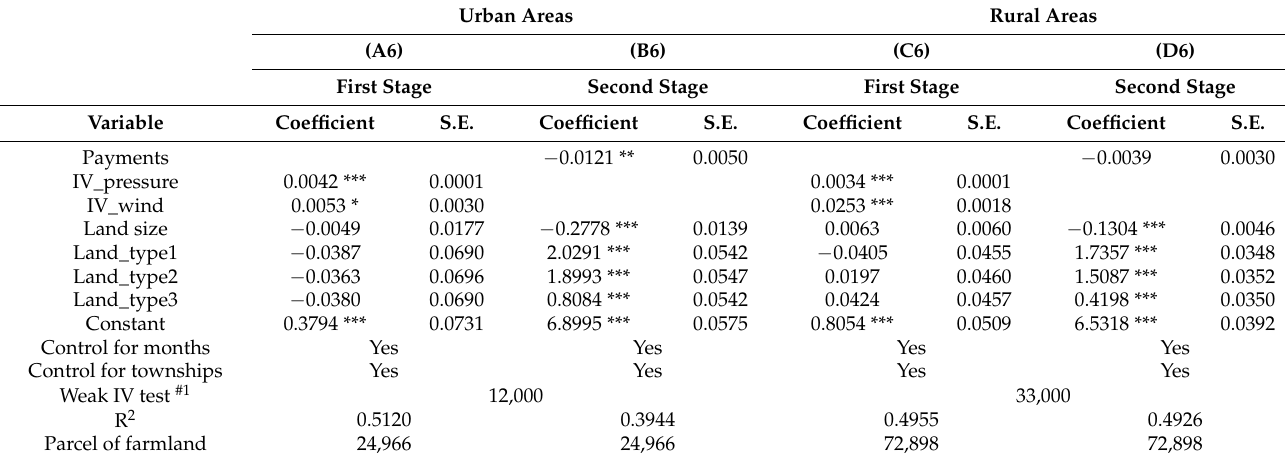
Table 6. Estimation results of the agricultural disaster relief payments on farmland prices by regions (IV-FE